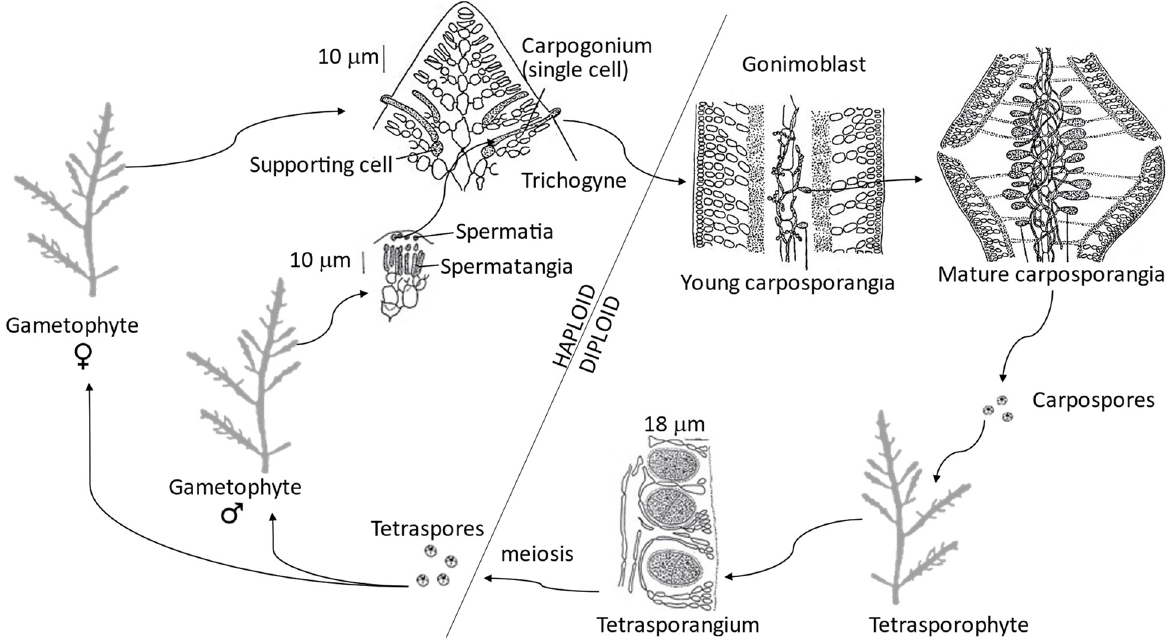
Figure 3. Triphasic isomorphic haplodiploid life cycle of Gelidium corneum , adapted from Lee [106].